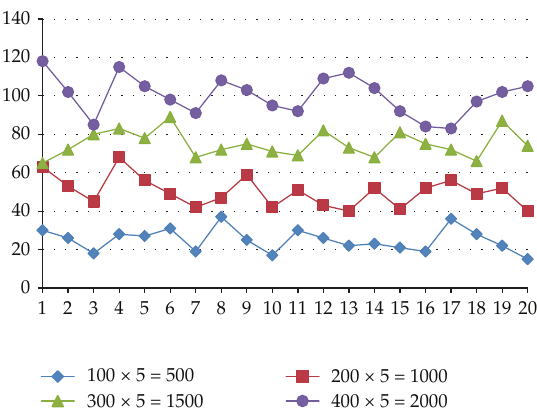
Figure 4: Files distribution over 10 device